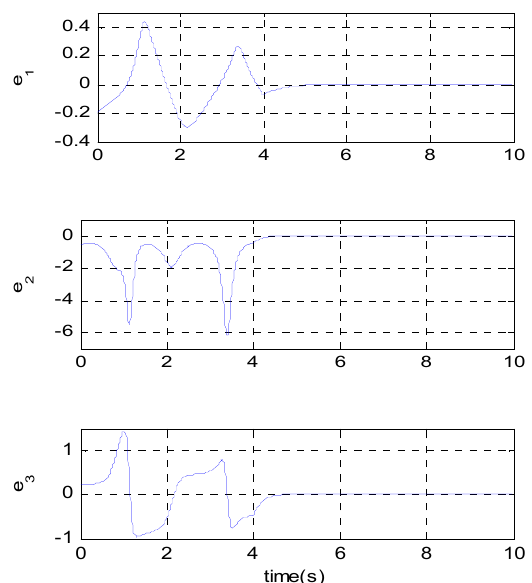
Figure 4. Time evolution of synchronization error signals by numerical simulation e 1 ( t ) , e 2 ( t ) and e 3 ( t )